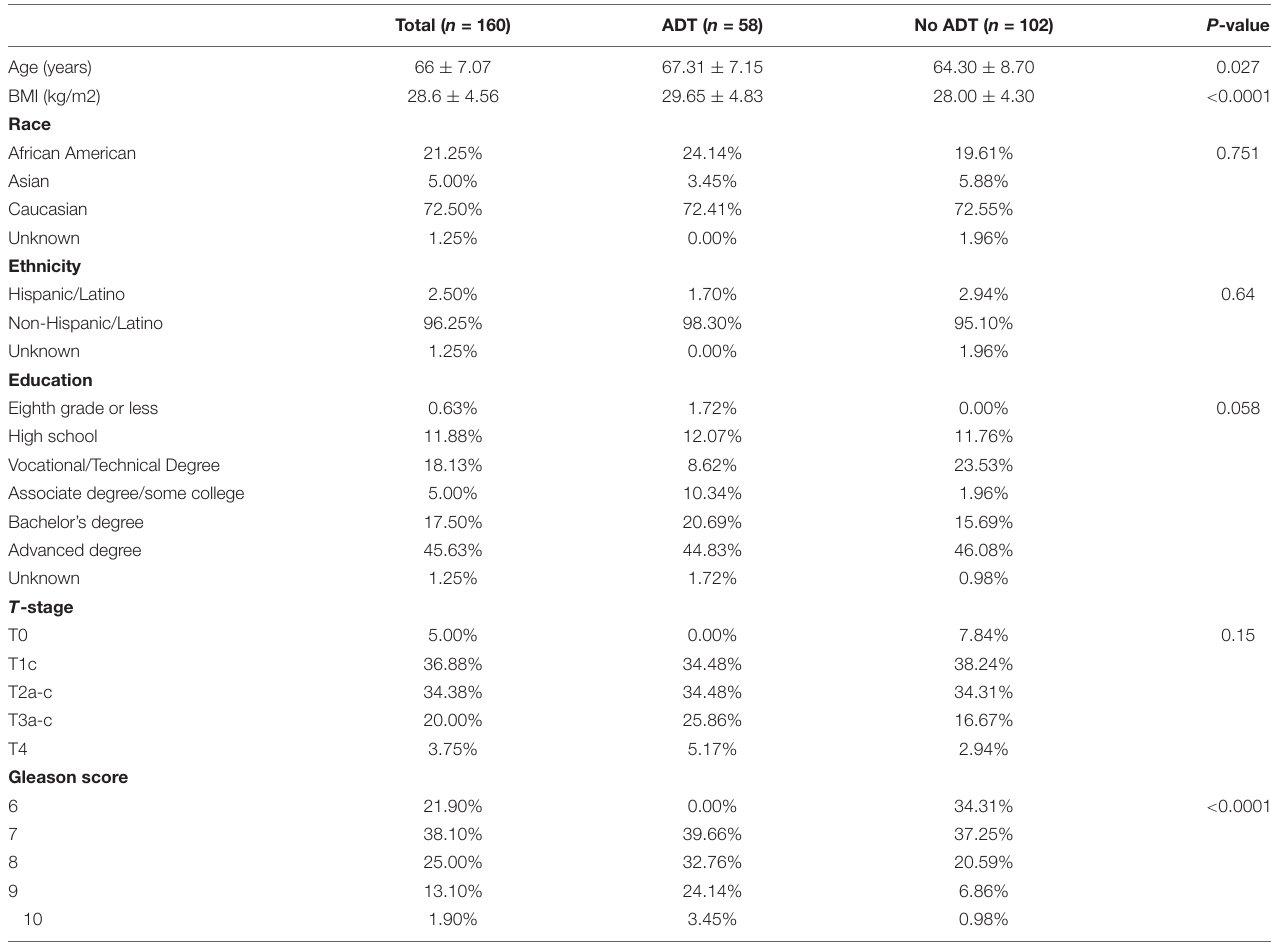
TABLE 1 | Demographics and clinical characteristics of sample